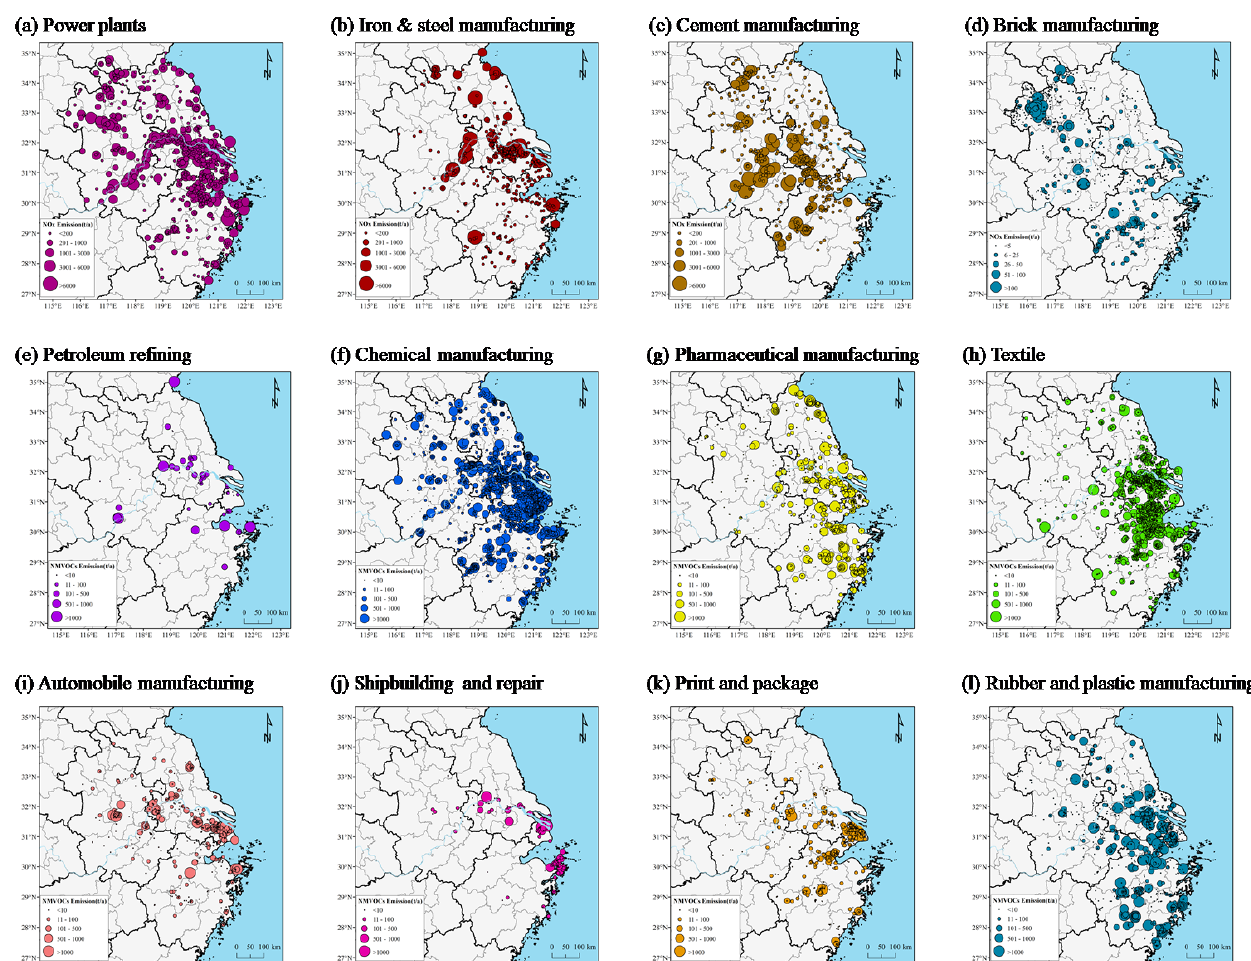
Figure 5. Spatial distribution of the major NO x and NMVOC emission sources in the YRD region.